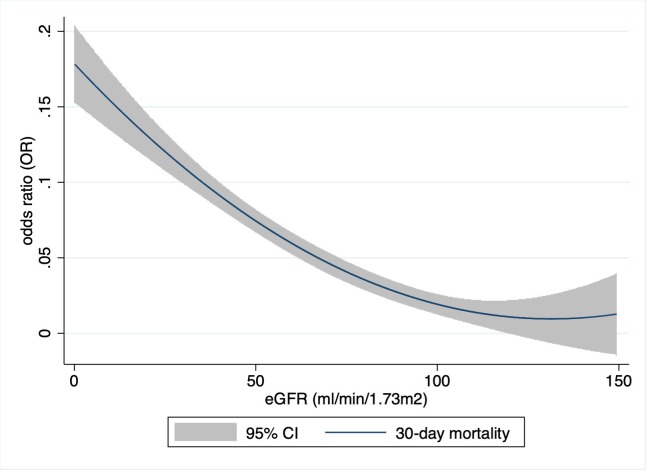
Hazard ratio of 30-day mortality as a function of eGFR.(x-axis, eGFR (ml/min/1.73m2), y-axis, odd ratio for 30-day mortality, CI, confidence interval).